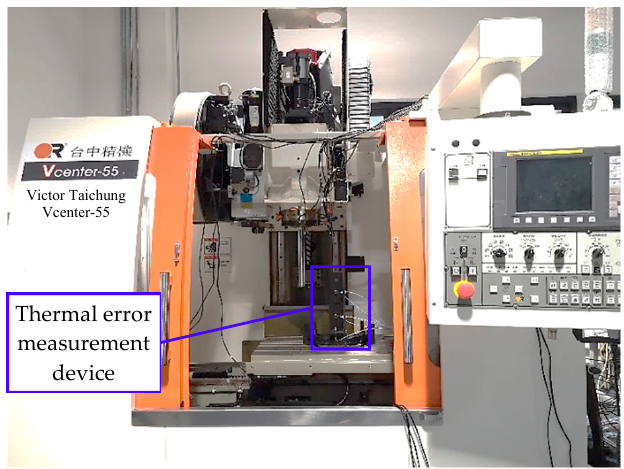
Figure 1. Experimental object.